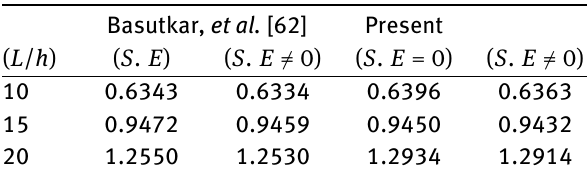
Table 7: Maximum transverse deflection in a C-C nanotube incorpo- rating surface effects